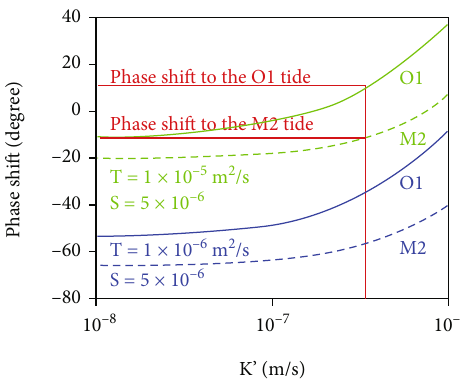
Figure 5: The analytical solution of the tidal response leaky model [9] for well Gaocun. According to the M this well, the most related analytical solution fi gure is chosen. ∗ T , S , and K ′ are in accordance with the explanations in the succeeding fi